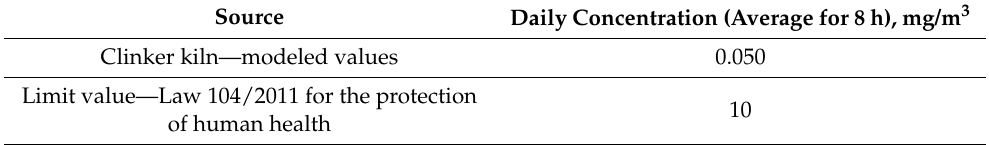
Table 10. Maximum CO concentrations extracted from modeling (daily). Source Daily Concentration (Average for 8 h), mg/m 3